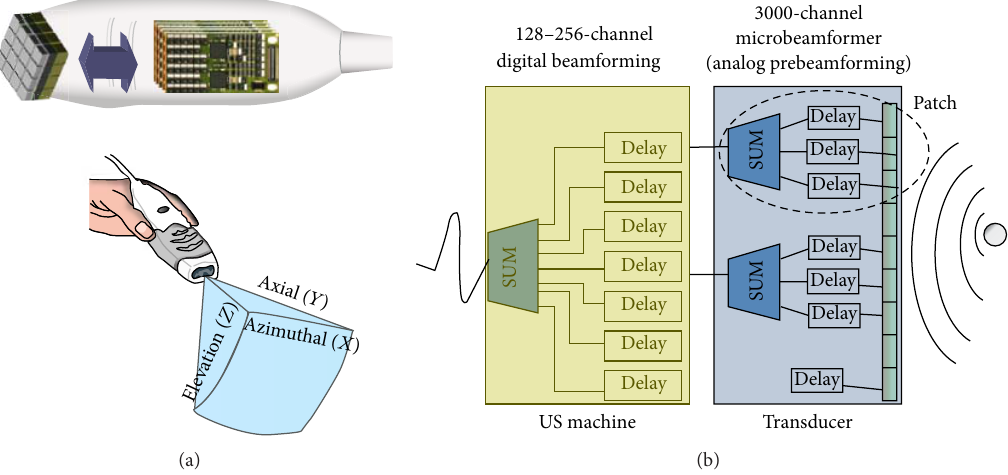
Figure 3: (a) Schematic drawing of a full matrix array transducer where about 3000 acoustically independent piezoelectric elements are arranged in row and columns and used to steer the beam electronically. This matrix arrangement of piezoelectric elements allows their phasic firing to produce an ultrasound beam that can be steered in vertical (axial), lateral (azimuthal), and anteroposterior (elevation) directions in order to acquire a volumetric (pyramidal) data set. (b) Beamforming with 3D matrix array transducers. To save power and electronic circuitry needs (costs) and reduce the connection cable size the beamforming and steering processes have been split into two: the transducer and the ultrasound machine levels. The transducer contains the piezoelectric elements arranged in a matrix array, interconnection technology and integrated analog circuits (DELAY)tocontroltransmitandreceive signalsusingdifferent subsectionsofthematrix(patches)tocontrol analog prebeamforming and fine steering. Signals from each patch are summed in order to reduce the number of digital lines in the coaxial cable that connects the transducer to the ultrasound system from 3000 to the conventional size of 128–256 channels. At the ultrasound machine level, analog-to-digital (A/D) convertors amplify, filter, and digitize the elements signals. The resulting digital signals are focused (coarse steering) using digital delay (DELAY) circuitry and summed together ( Ξ ) to form the received signal from a desired